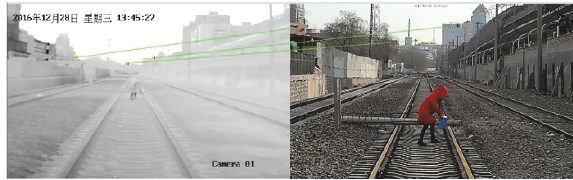
Figure 7: Result of RANSAC fine